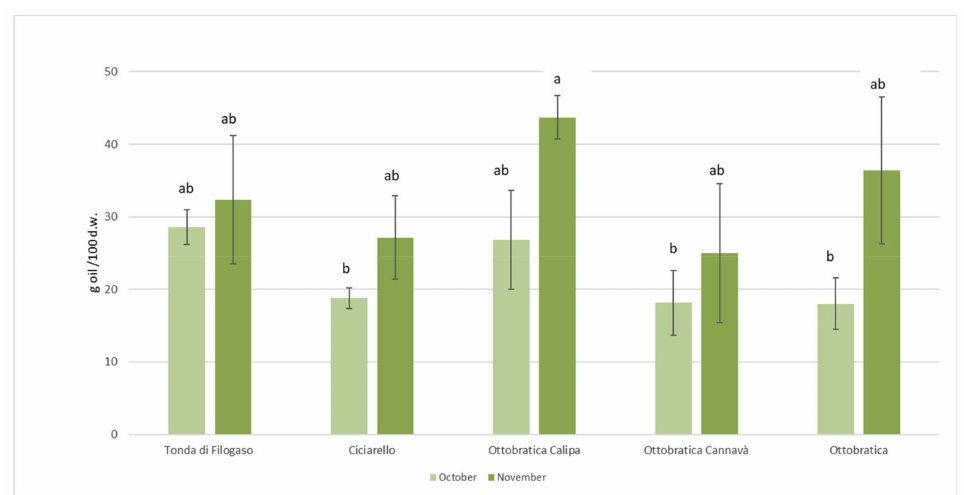
Figure 1. Olive oil yield at two harvesting times of the four studied minor varieties, with Ottobratica cv used as the reference for Calipa and Cannav à clones. Values are the means of 2017, 2018, and 2019. Different letters show significant differences at p < 0.05 by Tukey’s post hoc test. Table 1. Principal chemical parameters of olive oils of Tonda di Filogaso (TF), Ciciarello (C), Ottobratica Calipa. (O.